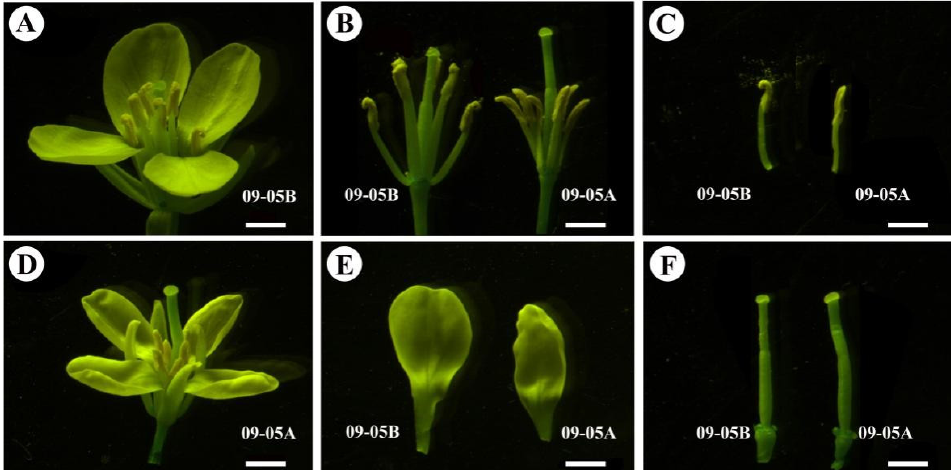
Figure 1. Morphological observation of floral organ between the male sterile line 09-05A and its maintainer line 09-05B of B. juncea at the blossom stage. ( A ) The flower bud of 09-05B. ( B ) Comparison of stamens and pistils of 09-05A/B lines. ( C ) Comparison of stamens of 09-05A/B lines. ( D ) The flower bud of 09-05A. ( E ) Comparison of petals of 09-05A/B lines. ( F ) Comparison of pistils of 09-05A/B lines. Bars = 2 mm.